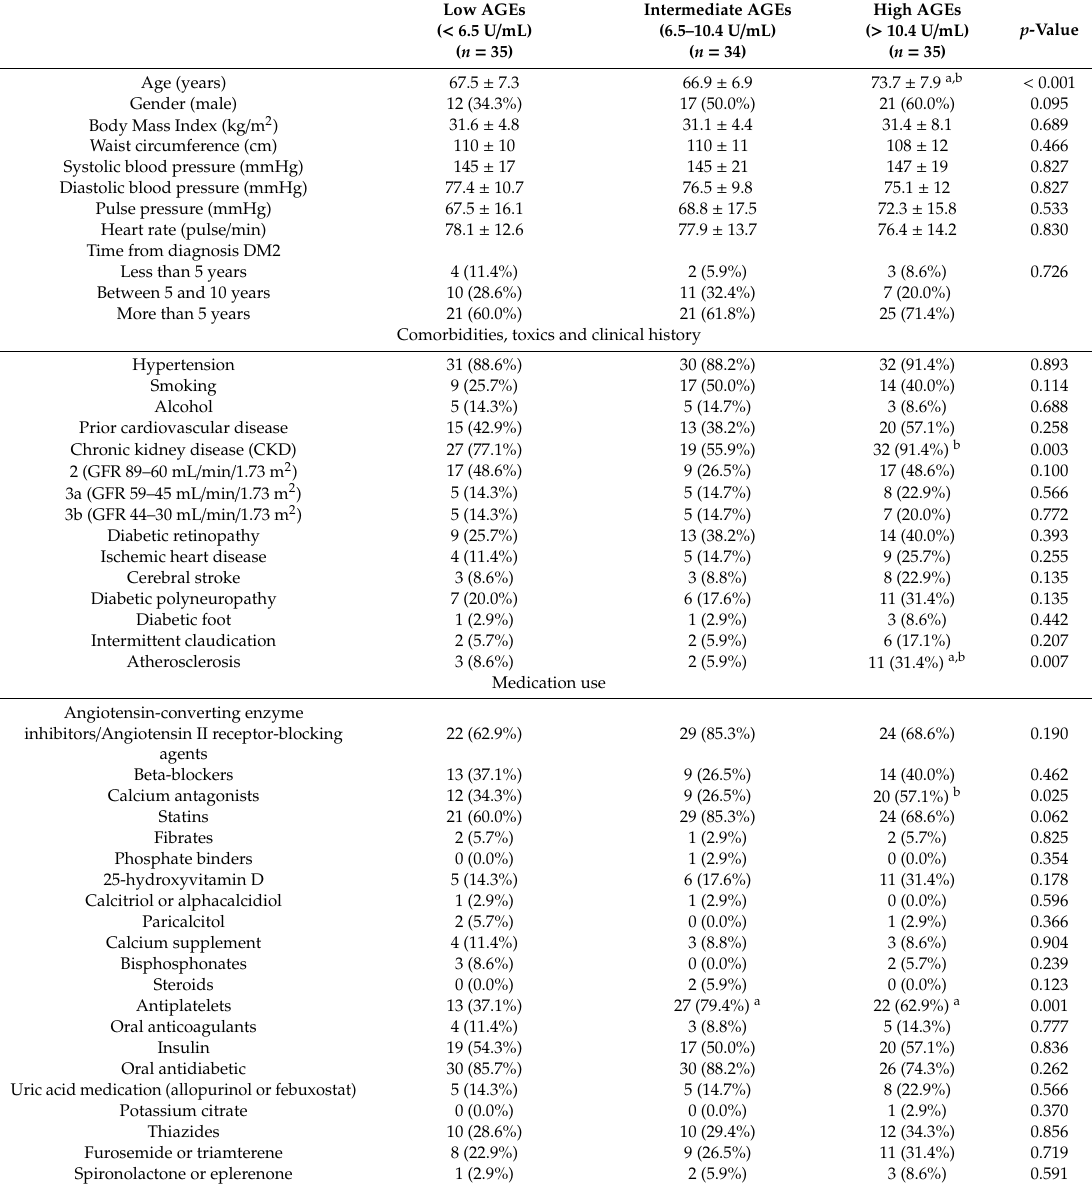
Table 1. Clinical characteristics of patients among circulating advanced glycation end products (AGEs)